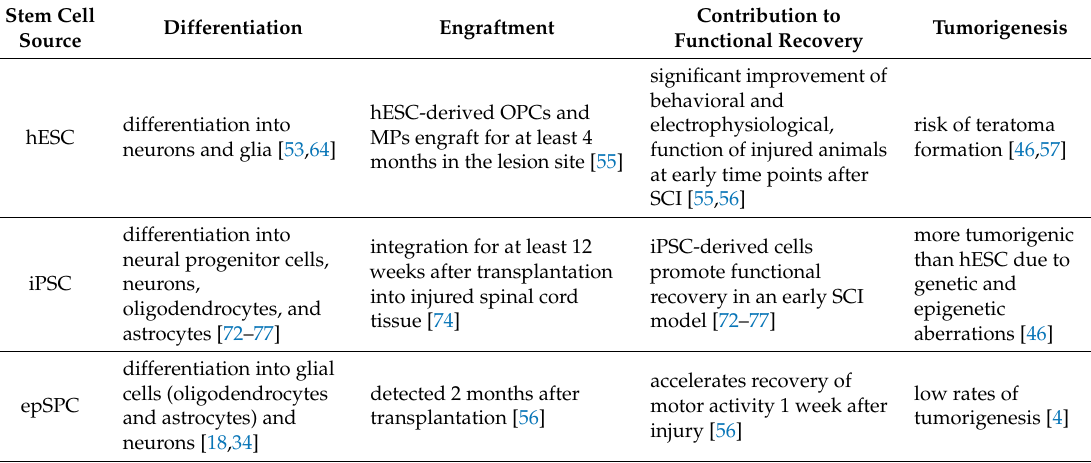
Table 1. The capacity of engraftment and differentiation, contribution to functional recovery and risk of tumorigenesis of transplanted hESC, iPSC and epSPC in animal model of spinal cord injury Stem cell